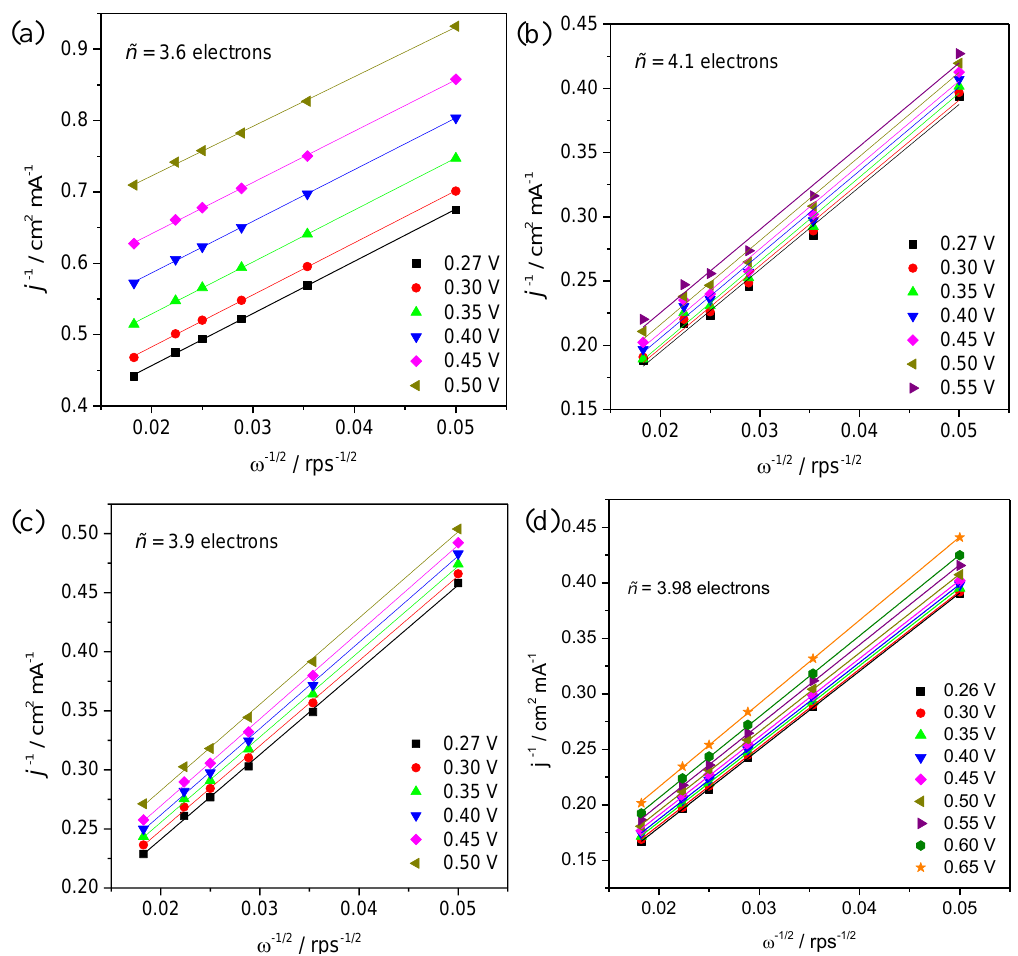
Figure 8. Koutecky–Levich (KL) plots obtained from the data in Figure 7 for S 3 N 2 –GF ( a ), Co / S 3 N 2 –GF ( b ), Mn/S 3 N 2 –GF ( c ) and commercial Pt/C (20wt%)-modified electrodes ( d ). Table 1. Onset potentials ( E onset ), diffusion-limiting current density values ( j L,0.26 V,1600 rpm ) and Tafel slopes determined from the ORR LSV curves in 0.1 mol dm -3 KOH and the number of electrons transferred for each O 2 molecule.